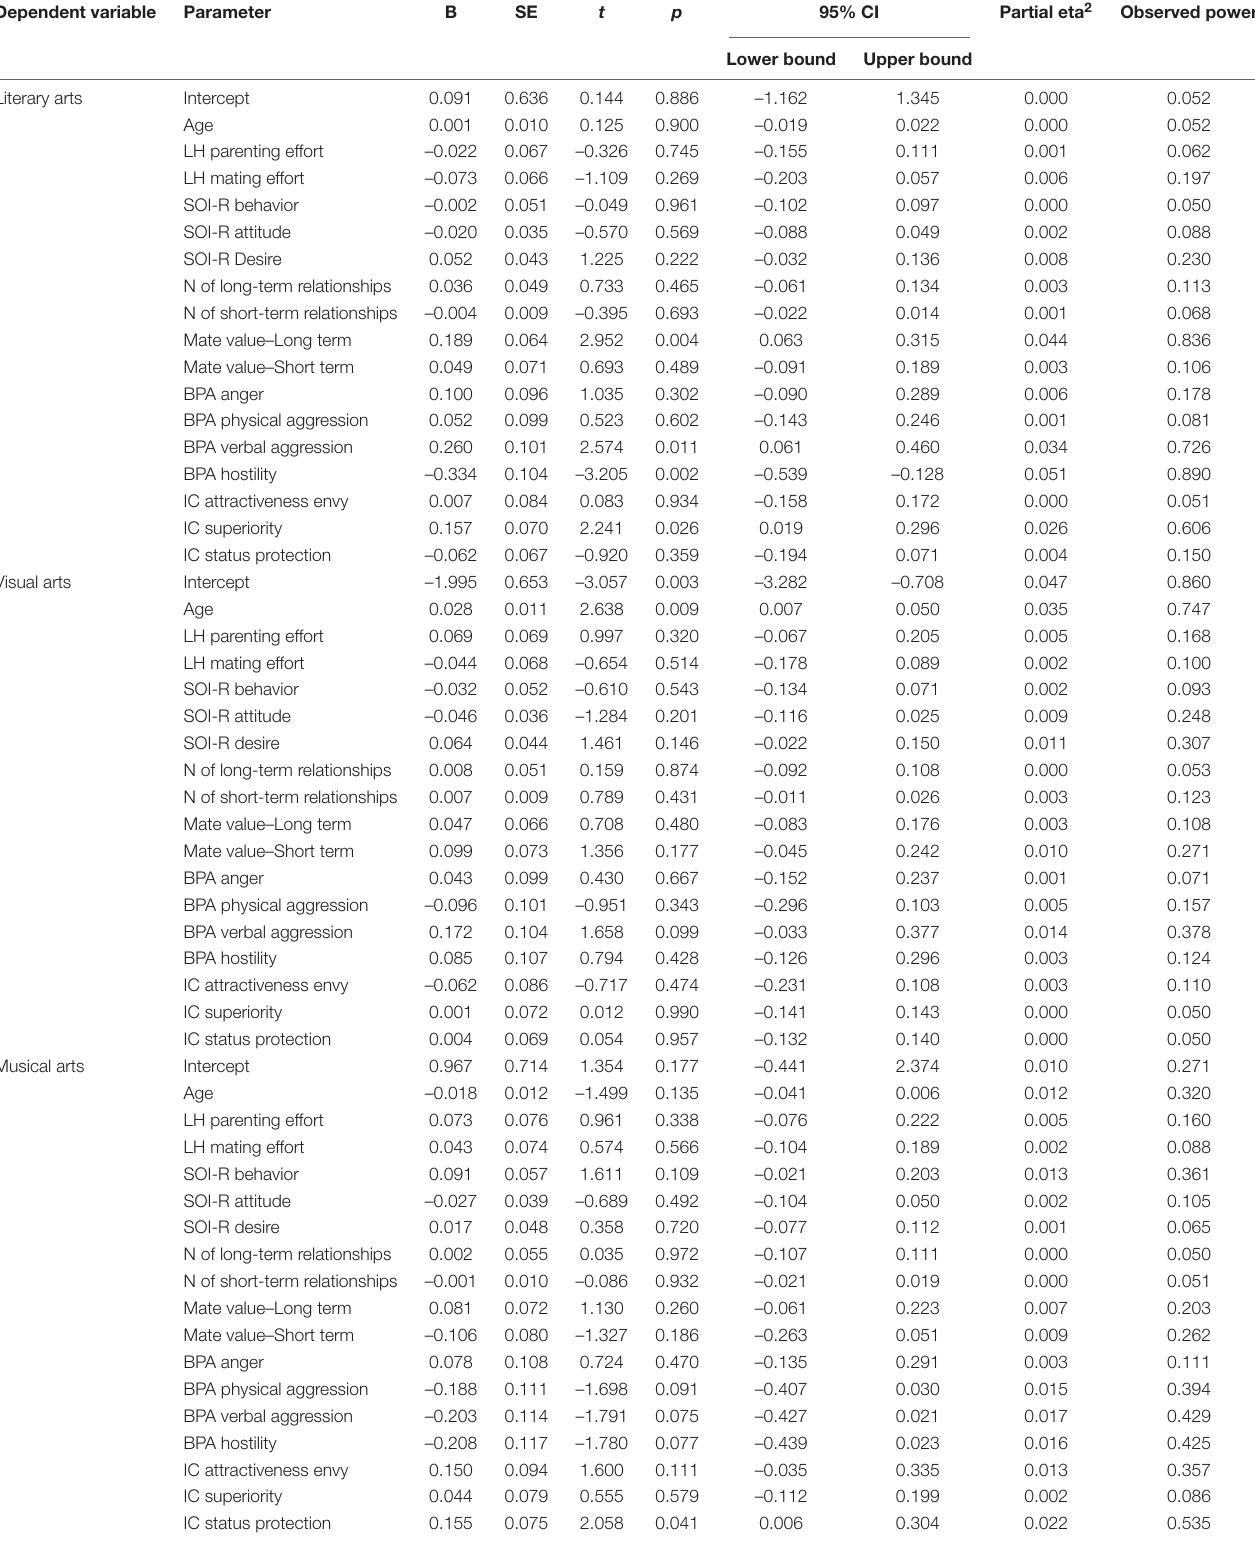
TABLE 3 | Parameter estimates of the general linear model (GLM) model indicating the effect of the independent variables on artisticality in men. Dependent